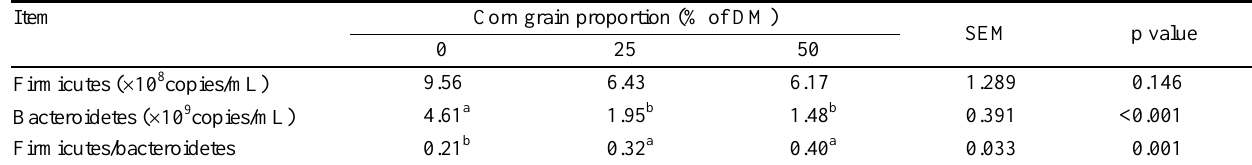
Table 4. The 16s rRNA gene copies of phylum Firmicutes and Bacteroidetes in rumen